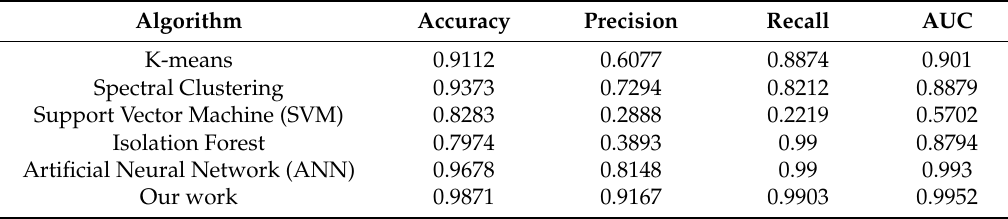
Table 3. The e ff ect of di ff erent algorithms.